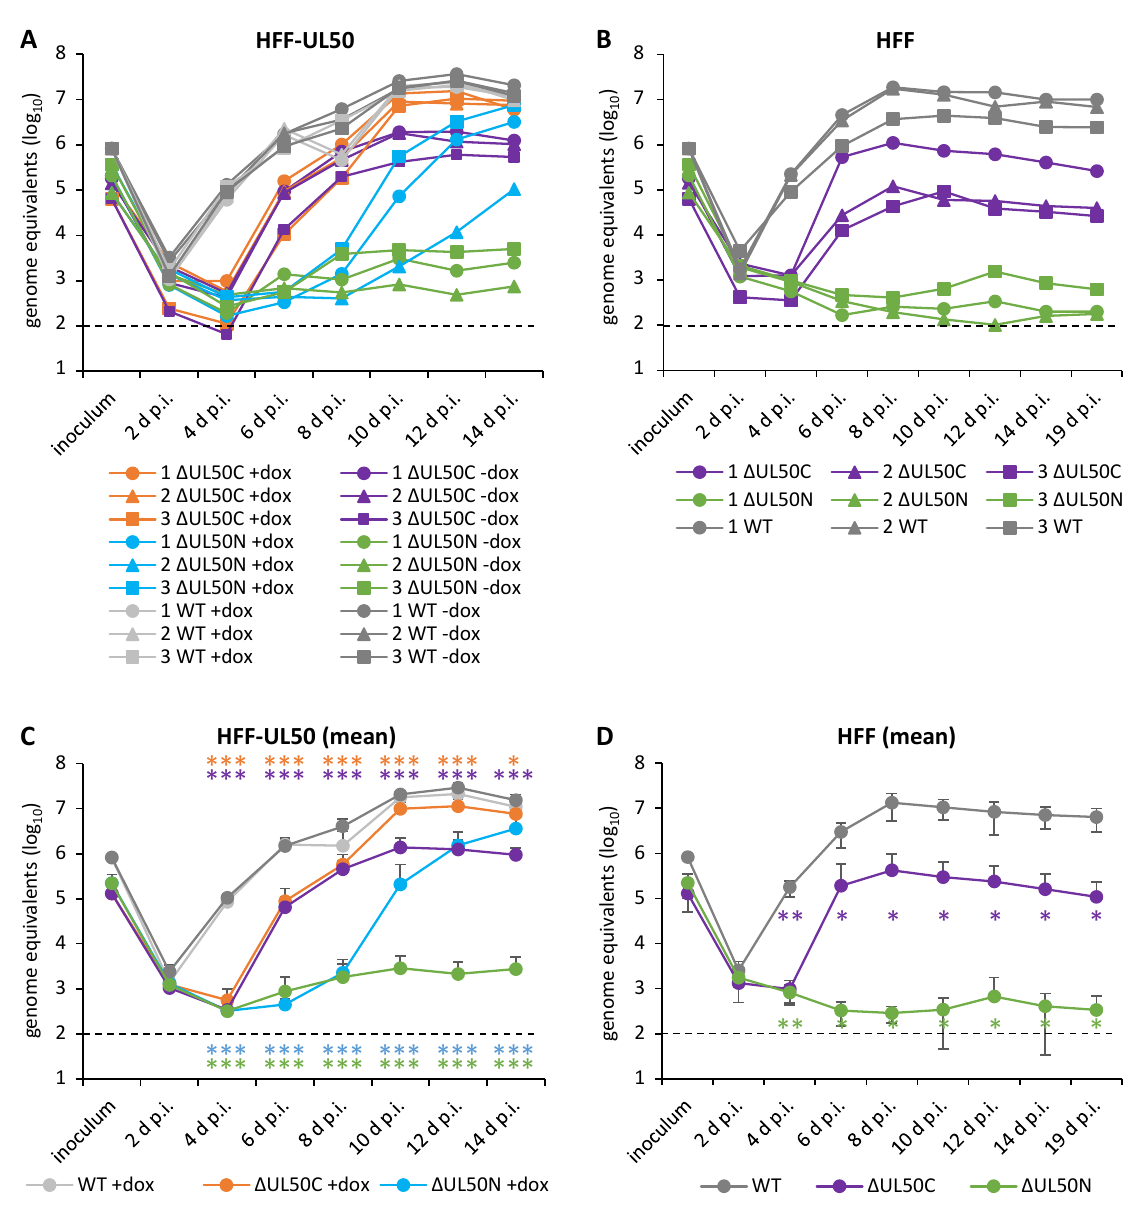
Figure 2. Replication kinetics of ∆ UL50C and ∆ UL50N show, in both cases, an impairment of replication efficiency in the absence of co-expressed pUL50. Infections were performed with the purified HCMV ∆ UL50C compared to ∆ UL50N particles, or parental HCMV AD169 (WT), using identical amounts of viral genomes contained in the inocula. HFF-UL50 cells were used, either in the induced (+dox) or uninduced (-dox) state of pUL50 expression, with values presented for the three individual purification replicates, labeled 1, 2, 3 ( A ), or as a mean of 1–3 ( C ). HFFs were used in analogous settings in parallel, also presented as individual values ( B ) or as a mean of 1–3 ( D ). IE1-specific qPCR was applied in duplicate measurements to detect the viral genome equivalents in supernatants harvested at the indicated time points. All infections were performed in triplicates, and mean values + SD are given in the curves. The standard containing 10 2 HCMV DNA copies reached the cycle threshold at cycle 38 and was, therefore, defined as the limit of detection (black dashed lines). Statistical significance of the values of genome equivalents was calculated by ANOVA (*, p ≤ 0.05; **, p ≤ 0.01; ***, p ≤ 0.001) for 2–19 d p.i. in relation to WT (for panel C, mean value of WT +dox and WT -dox).